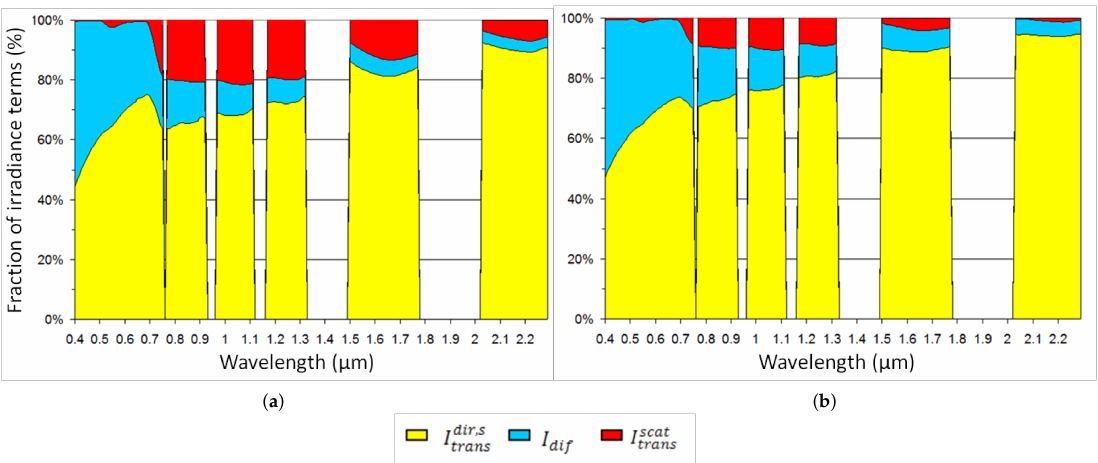
Figure 14. Spectral mean fraction of irradiance terms in total irradiance received at tree shadow for the TLS-based tree Figure 2. This is a wide figure. models and both ( a ) the linden and ( b ) the magnolia tree (SZA = 45 ◦ and BACKGROUND = grass). Table 6. Comparison of the normalized mean bias NB expressed in % between the reference TLS- based tree models and all tree models (first column: T stands for the number of the compared tree models) by either neglecting T dir or T scat at two spectral bands for the two tree species (SZA = 45 ◦ and BACKGROUND = grass). NB values are highlighted in green/yellow/orange/red for